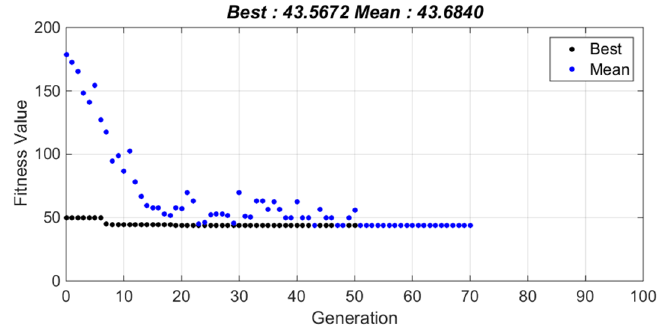
Figure 7. Convergence history of objective function, Design-3.